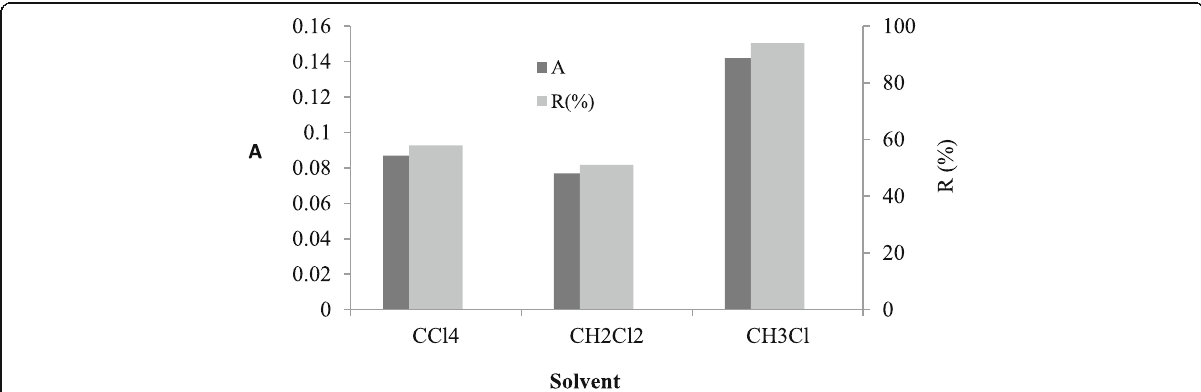
Fig. 3 Effect of the extraction solvent on the extraction of Cu(II) ions by DLLME method. Conditions: sample volume, 10.0 mL; Cu(II) ion concentration, 50.0 μ g L − 1 , solution pH = 2.0; salophen concentration, 2.0 × 10 − 5 M; disperser solvent (acetone) volume, 1.30 mL; diluting solvent (ethanol) volume, 140 μ L; centrifuge time, 5 min (at 5000